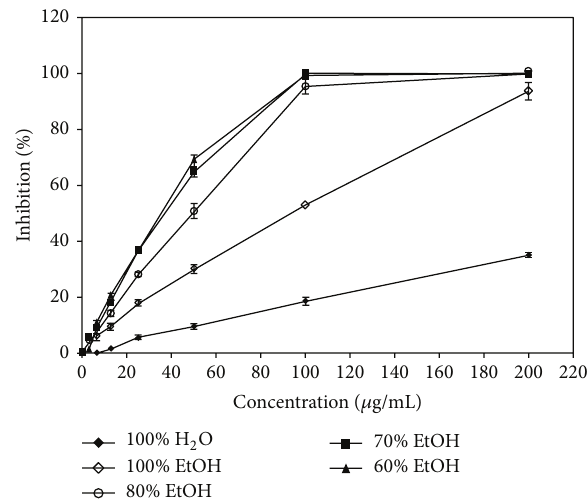
Figure 3: Free radical-scavenging activity of S . baicalensis extracts by ABTS assay. ( X ) Water, ( ⬦ ) 100% EtOH, ( I ) 80% EtOH, ( ◼ ) 70% EtOH, and ( 󳵳 ) 60% EtOH, results are mean ± S.D ( 𝑛 = 3 ).